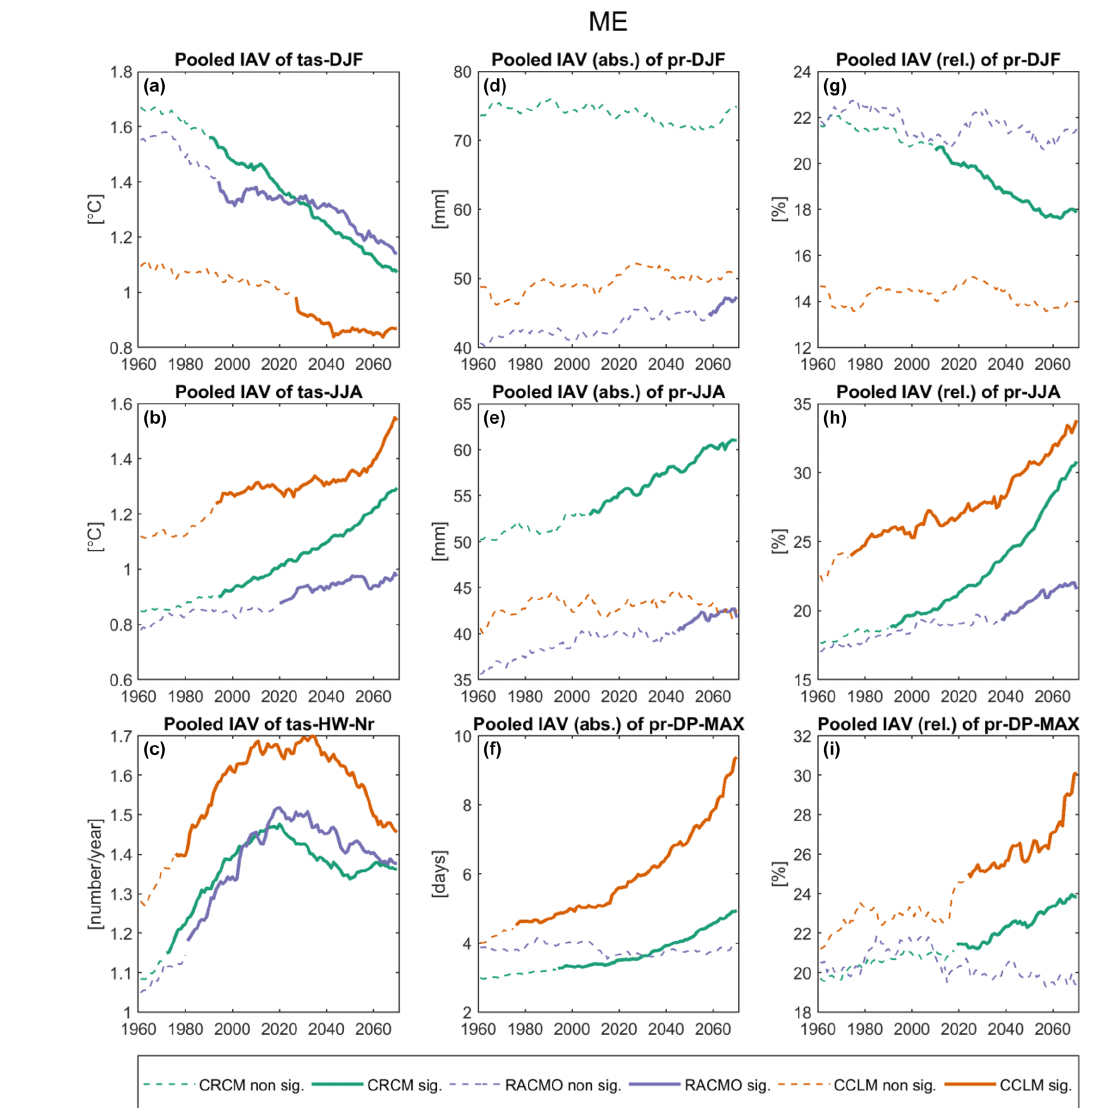
Figure 10. “Pooled IAV” for mid-Europe. The analysis is based on residuals, pooled together from all members, after removing the EM from each member. Temperature-based indicators are shown in absolute terms (a–c) . Precipitation-based indicators are shown both in absolute terms (d–f) and relative to the ensemble mean (g–i) . The change from dashed to solid lines marks the point in time when all following periods show significant changes in variance (BF Test with α = 0 . 0 .